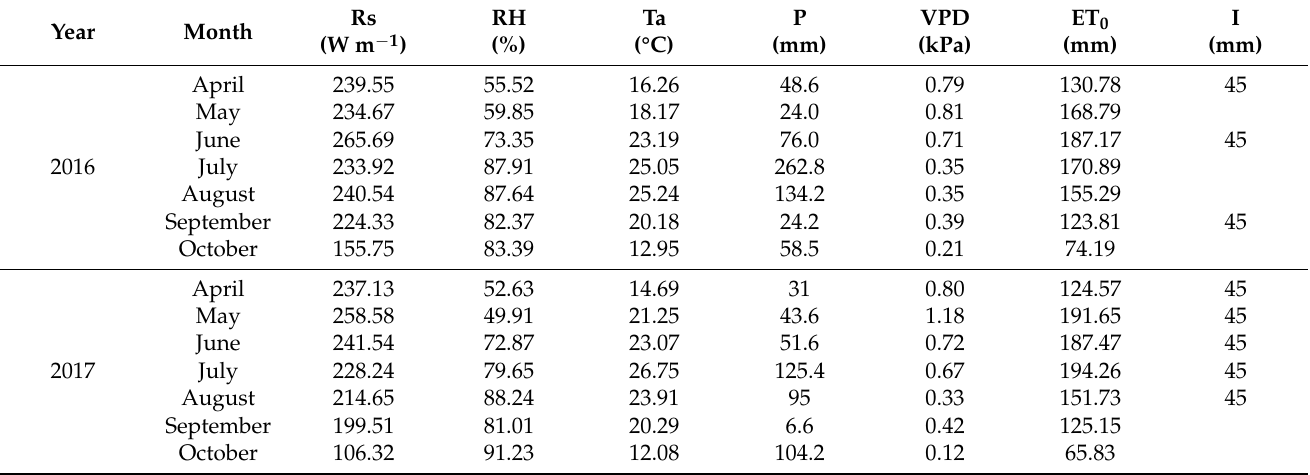
Figure 1. Air temperature, rainfall, and reference evapotranspiration (ET 0 ) in the growing seasons of apple in 2016 and 2017. Table 1. Monthly average solar radiation (Rs), mean relative humidity (RH), mean atmosphere temperature (Ta), mean vapor pressure deficit (VPD), total precipitation (P), total evapotranspiration (ET 0 ), and irrigation amount (I) in 2016 and 2017.